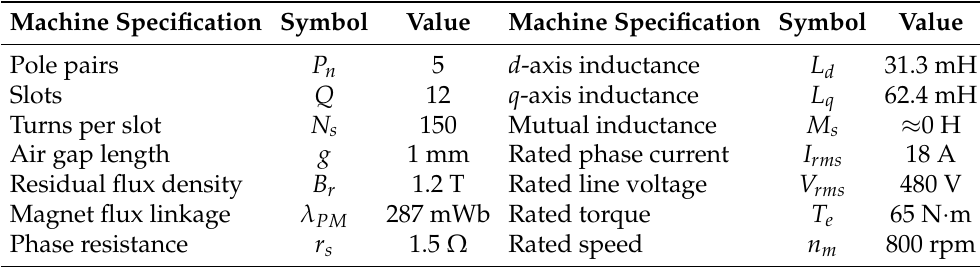
Table 1. Nameplate data of the studied PMSM.